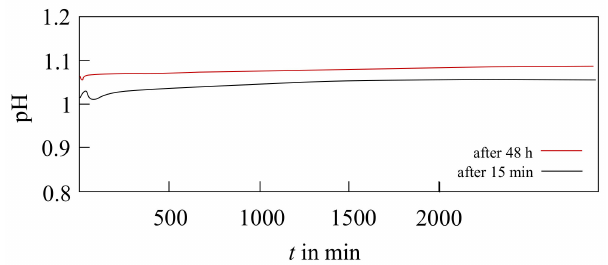
Figure 3. Change in pH value of electrolyte at rest over time, 15 min after preparation and after stirring for 48 h.